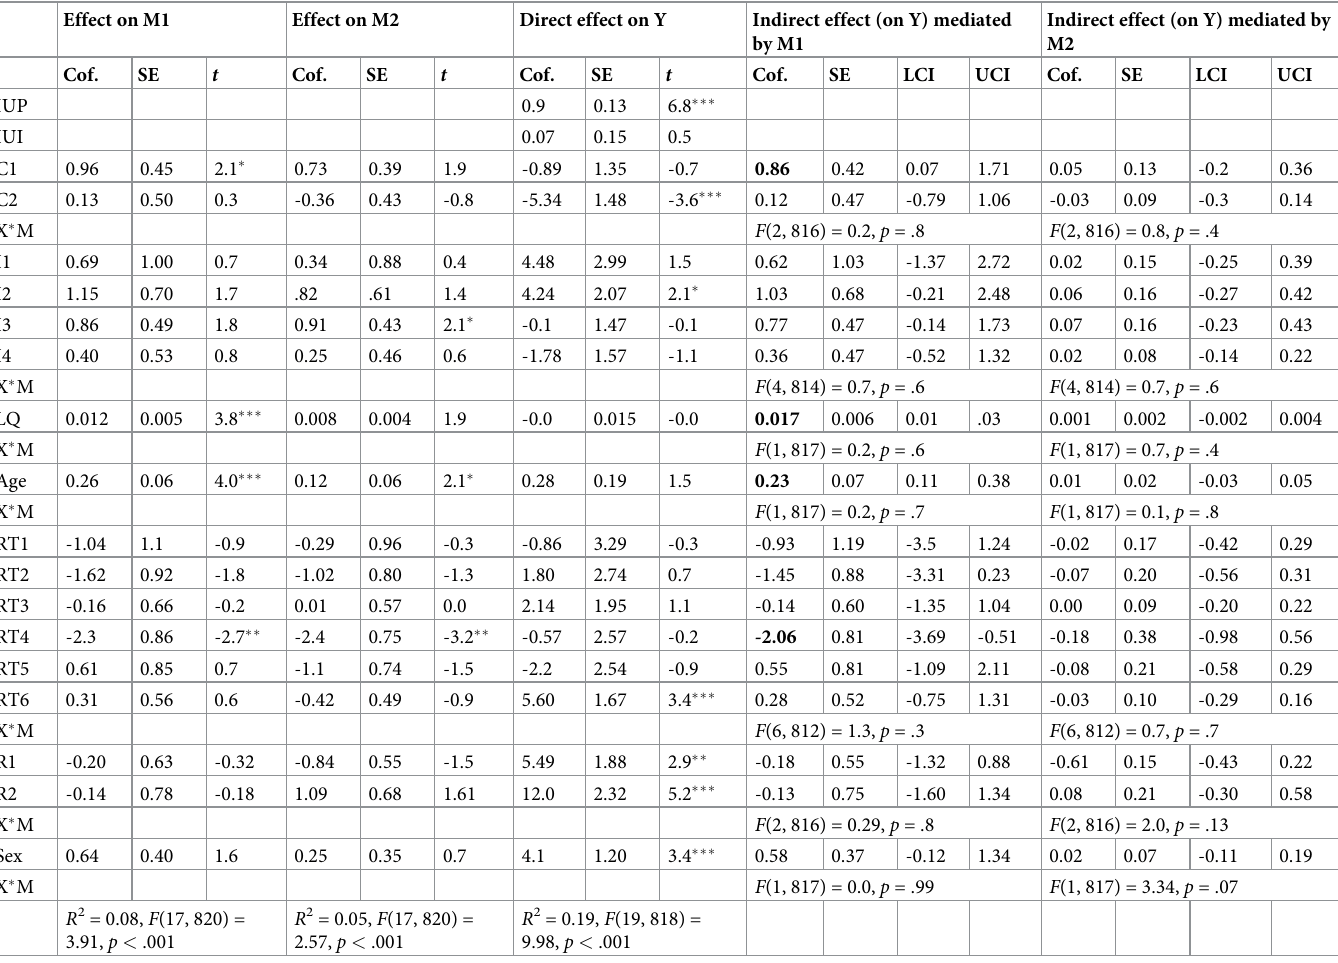
Table 3. The effects (direct and indirect) of antecedent and mediation (prospective IU & inhibitive IU) variables on religiousness in the students’ sample. Effect on M1 Effect on